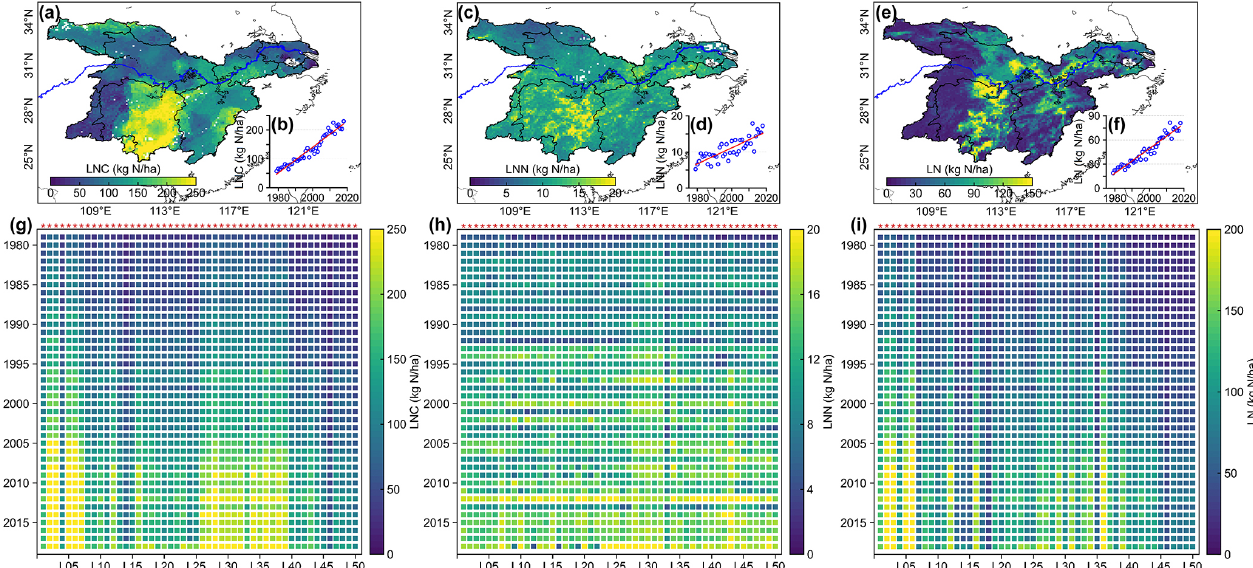
Figure 6. Tempo-spatial patterns of leached nitrogen from cropland (LNC), leached nitrogen from natural land (LNN), and total leached nitrogen (LN) for the period of 1979–2018. Spatial distributions of climatological (a) LNC, (c) LNN, and (e) LN. The insets (b) , (d) , and (f) represent the long-term changes of mean LNC, LNN, and LN, where the red lines are the linear fitting lines between years and nitrogen leaching. Inter-annual changes of (g) LNC, (h) LNN, and (i) LN for all examined lakes (L01–L50) from 1979–2018. Statistically significantly positive trends ( p < 0.05) are annotated with “ ∗ ” on top of the panel, and see Fig. 1 for ID numbers of